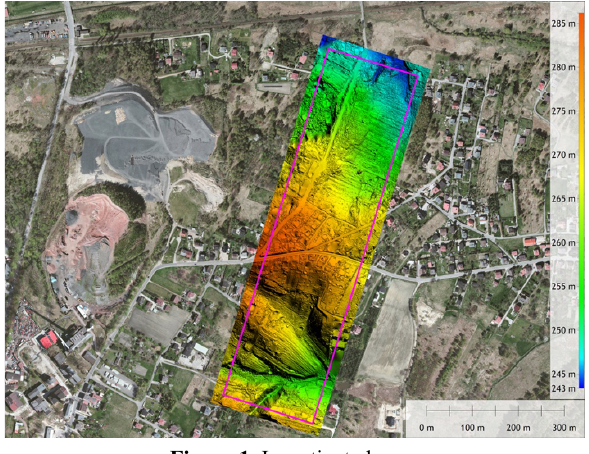
Figure 1 . Investigated area.